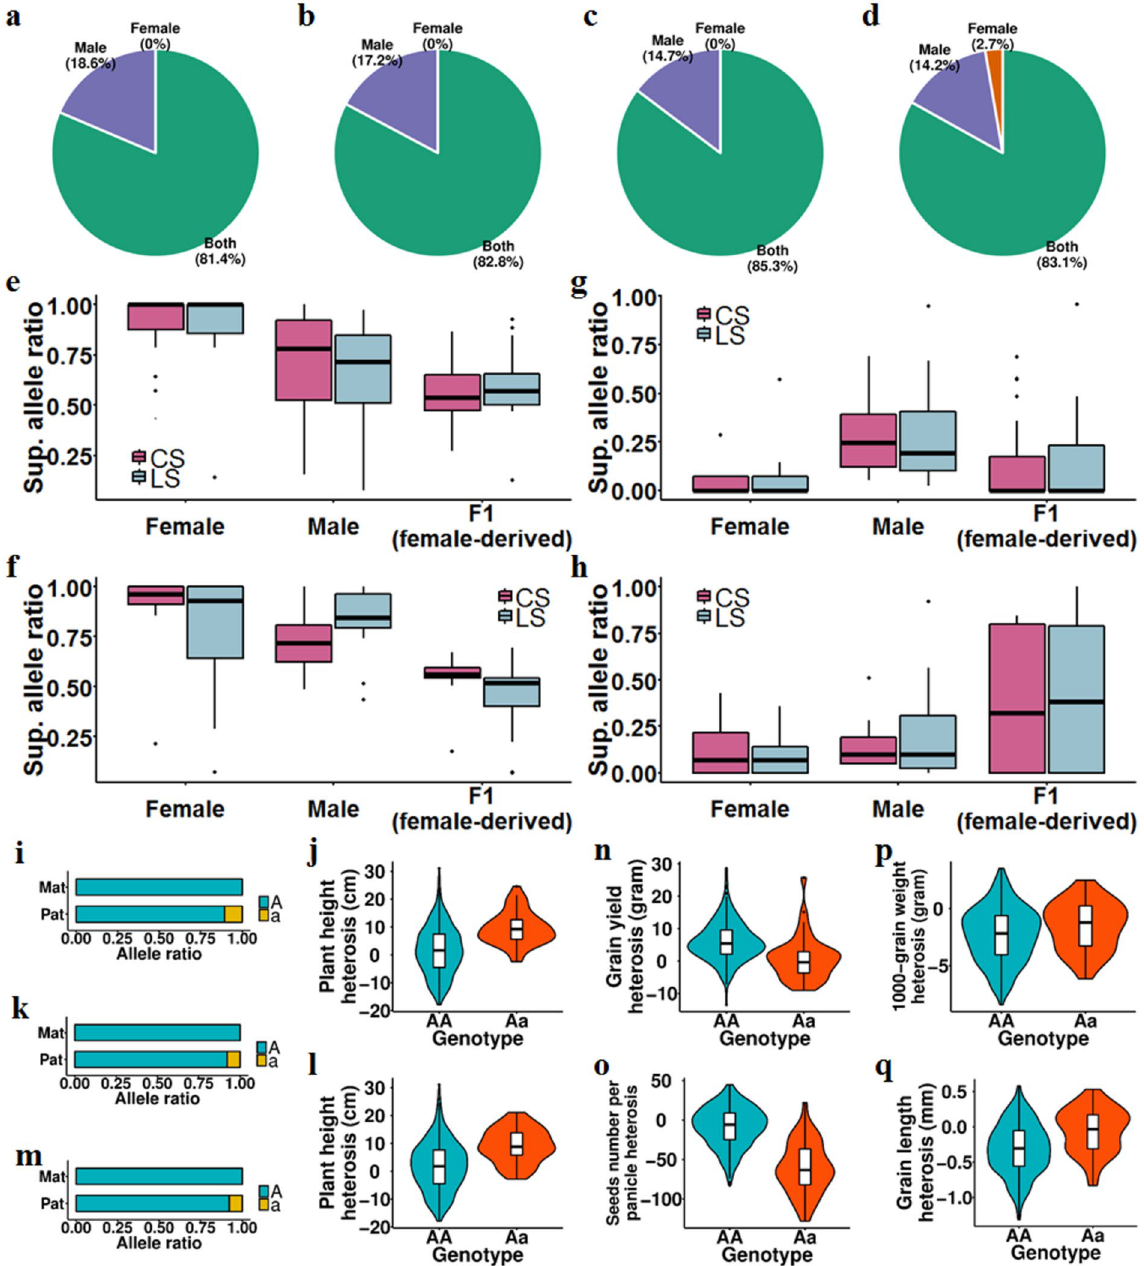
Figure 5. Male sterile lines and restorer lines made different superior allele contributions to F1 hybrids. ( a–d ) Superior allele contributions from either parental group for QTLs identified in the BPaV GWAS (a for CS, b for LS) and SCA GWAS (c for CS, d for LS). Two-genotype QTLs were separated into three groups: those with superior alleles contributed only by the restorer lines (male), only by the male sterile lines (female), and by both parental groups (both). ( e–h ) Superior allele ratios of male sterile lines, restorer lines, and F1 hybrids in homo-superior QTLs (e for BPaV GWAS results, f for SCA GWAS results) and hetero-superior QTLs (g for BPaV GWAS results, h for SCA GWAS results). ( i ) Allele ratios of the QTL harboring OsGLU1 in both parental groups. ( j ) PH_BPaV distributions of the QTL harboring OsGLU1 . ( k ) Allele ratios of the QTL harboring OsPDK1 in both parental groups. ( l ) PH_BPaV distributions of the QTL harboring OsPDK1 . ( m ) Allele ratios of the QTL harboring qGL3 in both parental groups. (n-q) GYPP_BPaV ( n ), SNPP_BPaV ( o ), TGW_BPaV ( p ), and GL_BPaV ( q ) distributions of the QTL harboring qGL3